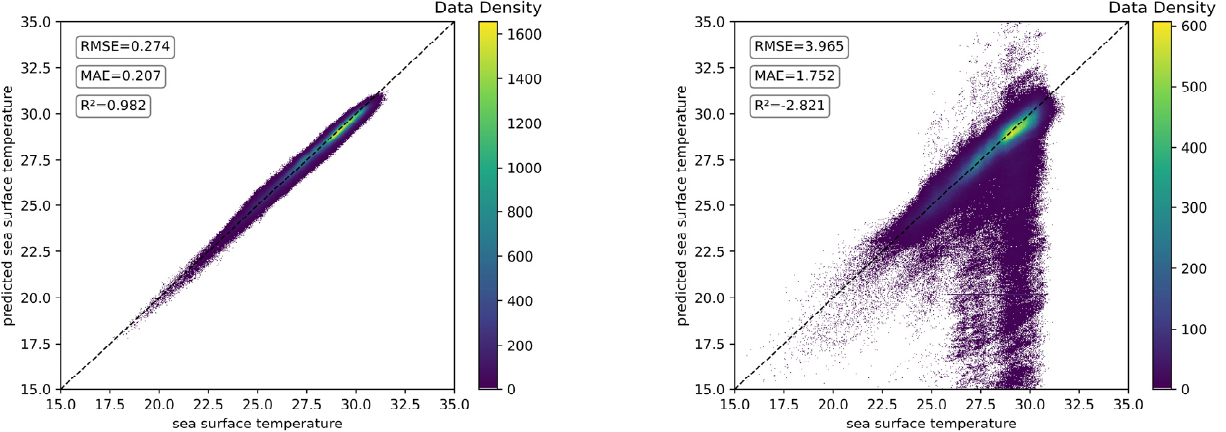
Figure 11. Comparison of SST prediction performance using ST-ConvLSTM. On the left, the hidden size is set to 64, and on the right, it is set to 2.